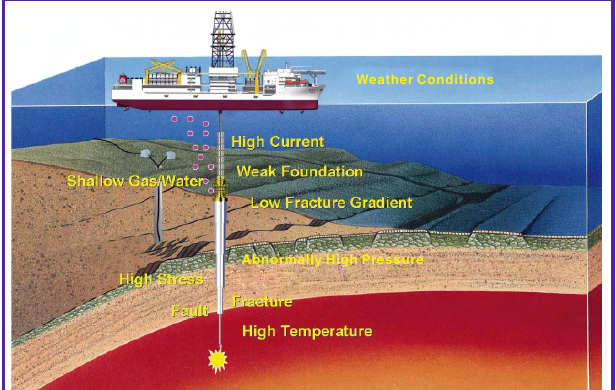
Figure 1. Potential drilling hazards.